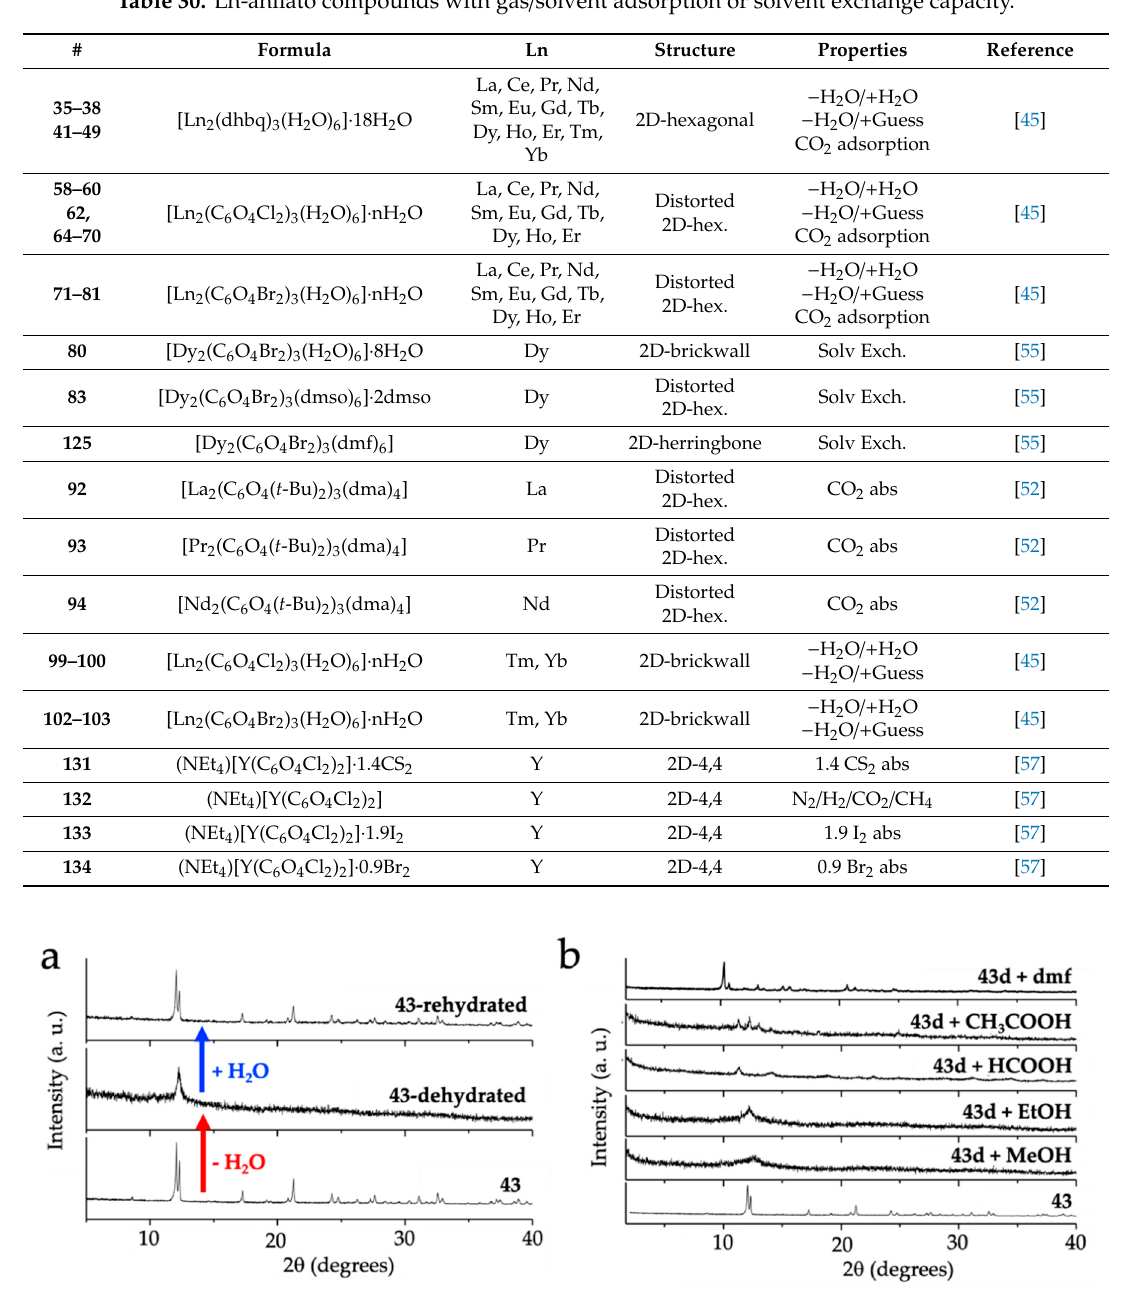
Table 30. Ln-anilato compounds with gas / solvent adsorption or solvent exchange capacity.